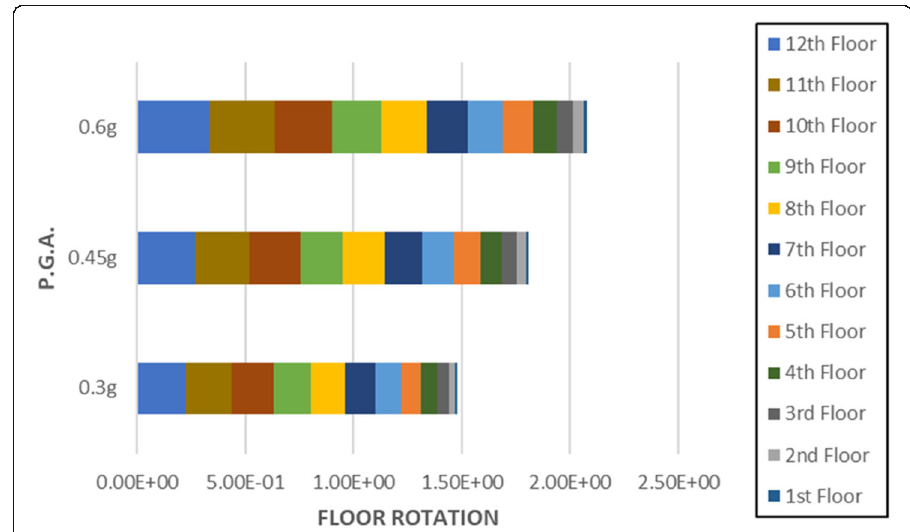
Fig. 29 Comparison of floor rotations — P.G.A. for (DS1-1, DS2-1, and DS3-1) (color should be used for this figure)